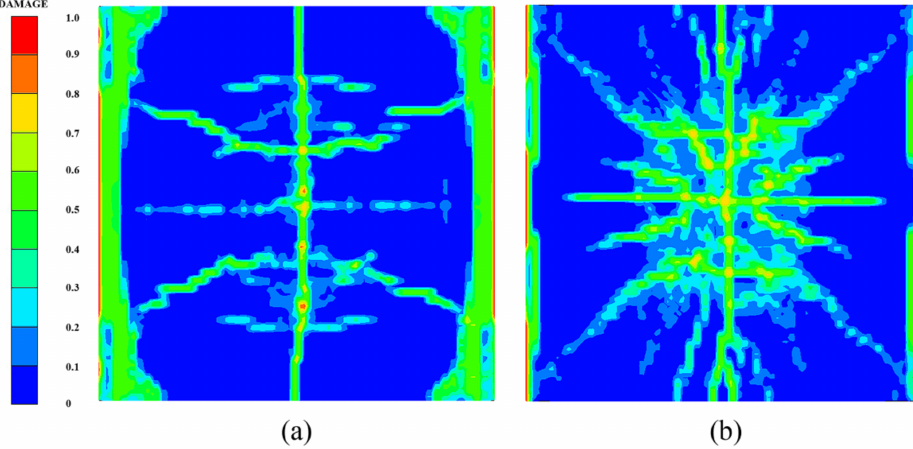
Figure 15. Numerical results of the ALE coupling model: ( a ) top surface; ( b ) bottom surface.